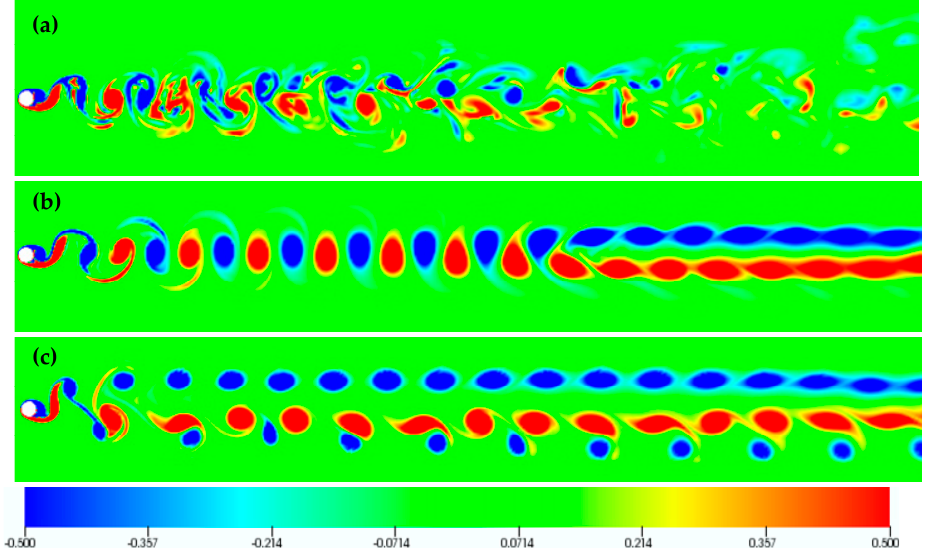
Figure 15. Clockwise cylinder oscillation: Instantaneous isocontours of spanwise vorticity for the plane z = 3 for F = 1.0 and ( a ) A y /D = 0.10, ( b ) A y /D = 0.20, ( c ) A y /D = 0.30. For the case of F = 1.1 and counter-clockwise cylinder oscillation, flow visualizations are presented in Figures 16 and 17, for transverse oscillation amplitudes of 0.20, 0.30 and 0.40. For the lower oscillation amplitude (A y /D = 0.20) a nearly two-dimensional vortex street is initiated, and modified farther downstream by vortex pairing, which gives rise to a stronger flow three-dimensionality. For A y /D = 0.30, the 2S structure persists farther